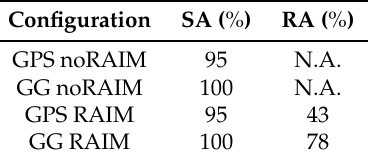
Table 2. Solution availability (SA) and reliable availability (RA) of the different solutions. GG, GPS and Galileo.